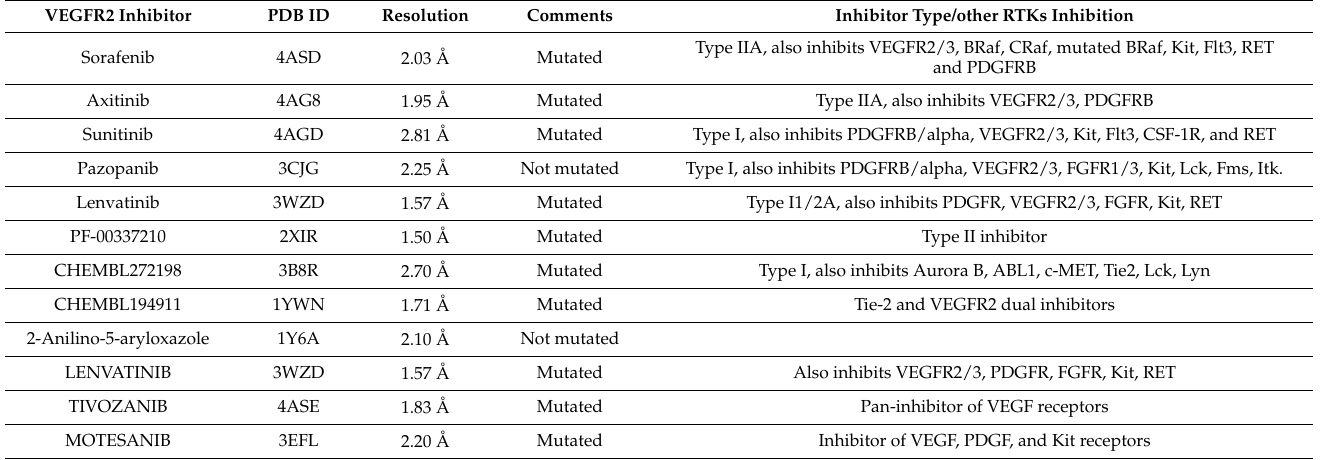
Table 2. An overview for some Vascular Endothelial Growth Factor Receptor-2 inhibitors, their PDB-ID, resolution, and their effects on other receptor kinase targets.